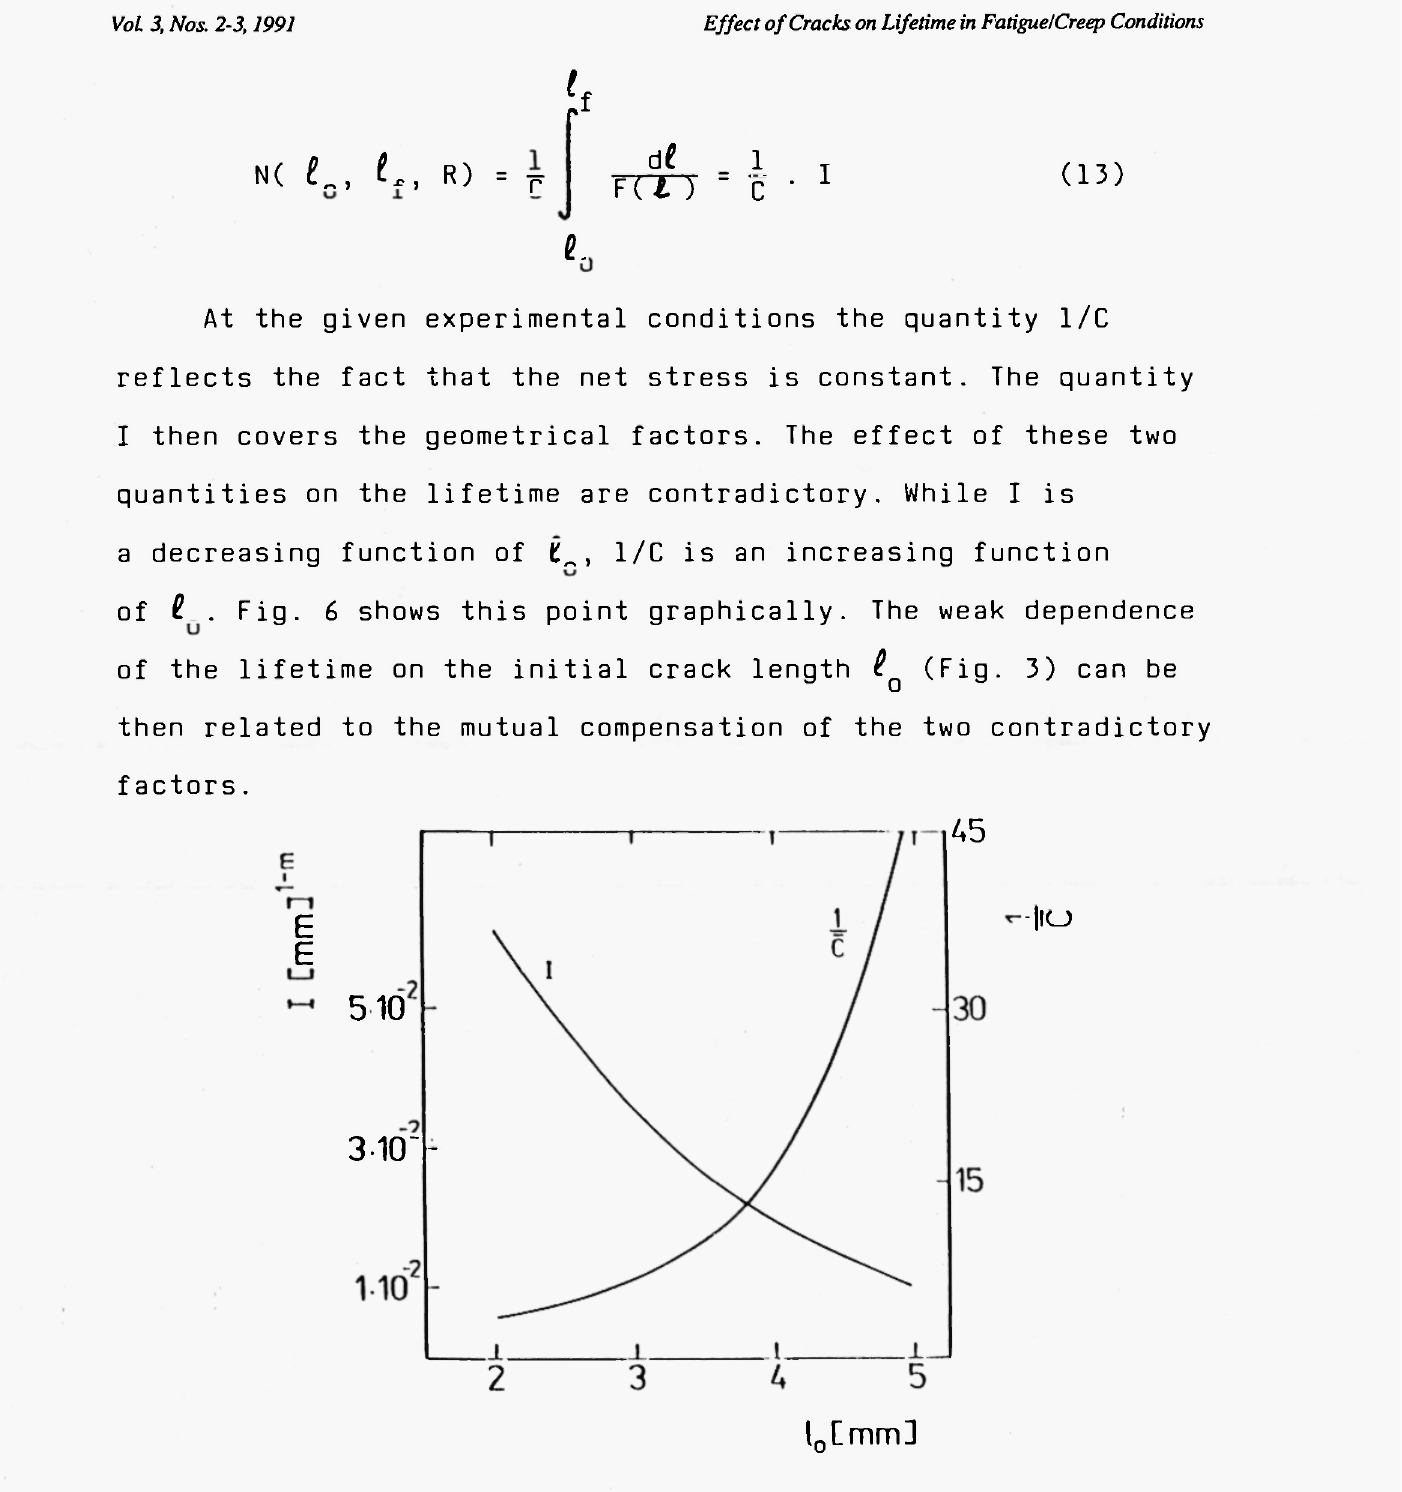
Fig. 6: Quantity I (eq. 13) and normalized values of C (eq. 11) in dependence on the initial crack length (for m =